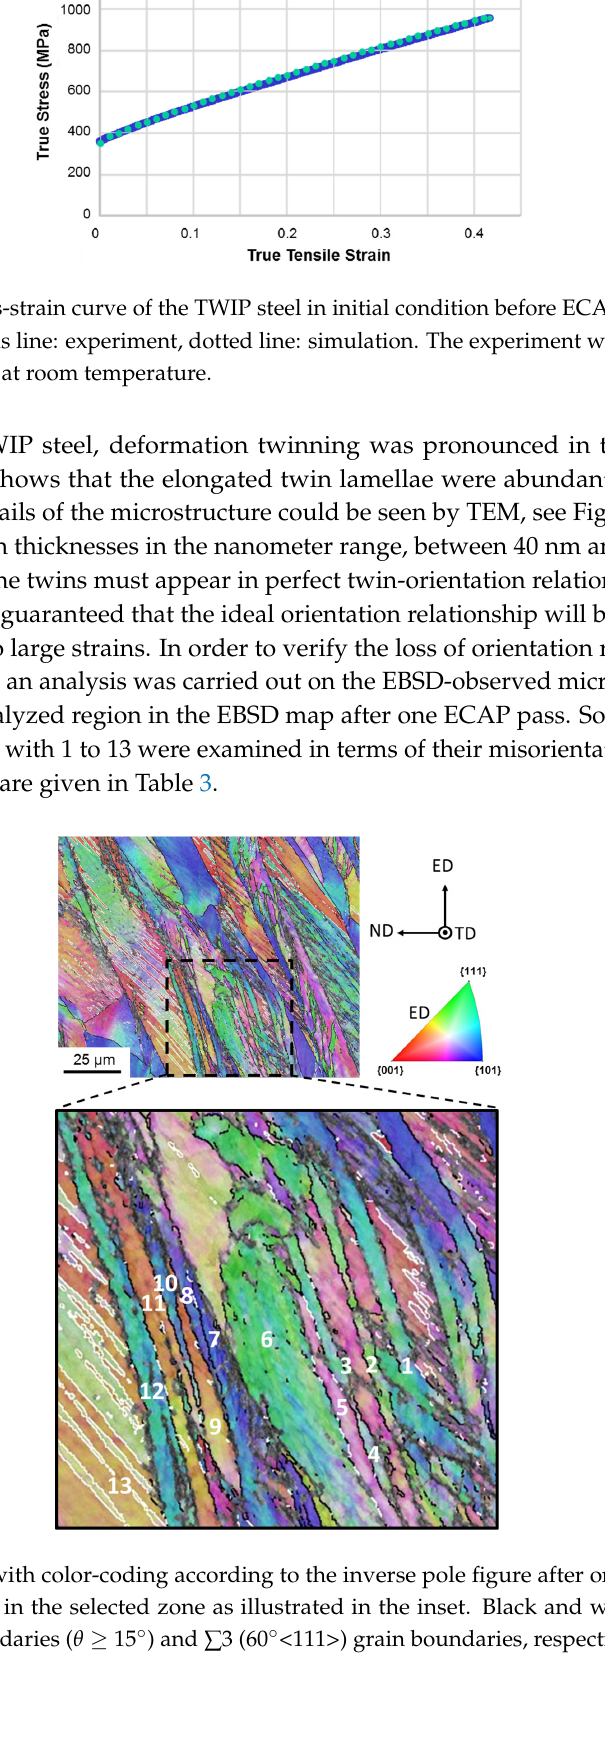
Figure 5. Bright field TEM micrograph and the corresponding selected area diffraction pattern after one ECAP pass showing a high fraction of deformation twins. Selected twins/twin ‐ matrix lamellae are indicated by arrows. Table 4 contains the results of the twin ‐ orientation analysis, i.e., the disorientation angle of each pair of neighboring grains together with their nearest disorientation axis, the offset from the nearest rotation axis, and the deviation angle from the ideal 60°<111> twinning orientation relationship. The deviations were typically around 10°, but there were also several larger disorientations, up to 50°. This analysis provided evidence that the twins drifted away from their initial ideal orientation